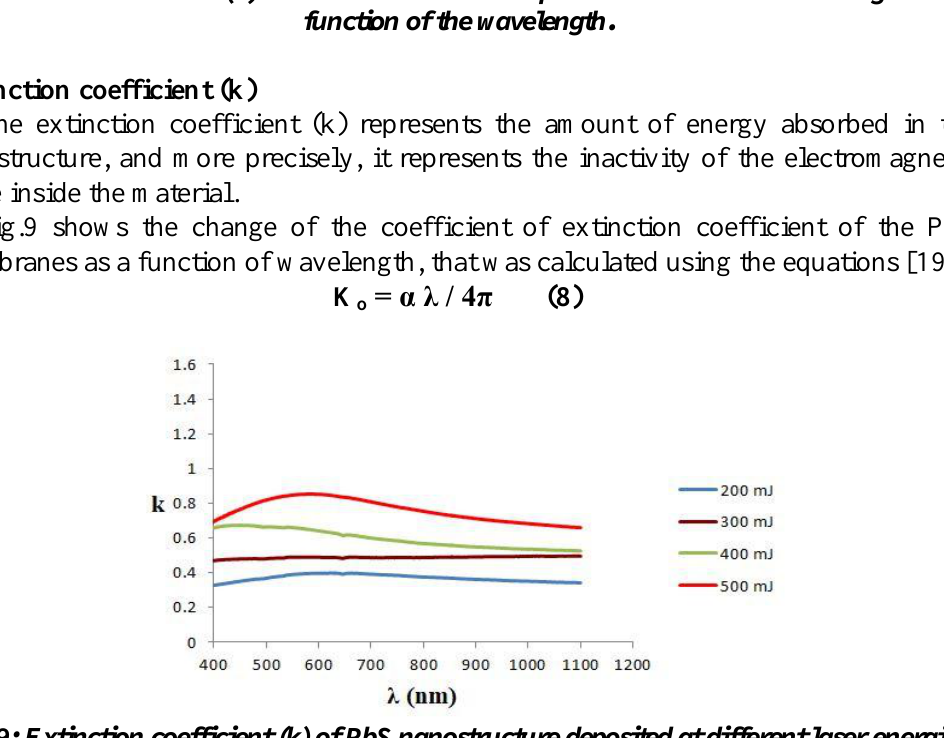
Fig.9: Extinction coefficient (k) of PbS nanostructure deposited at different laser energies as a function of